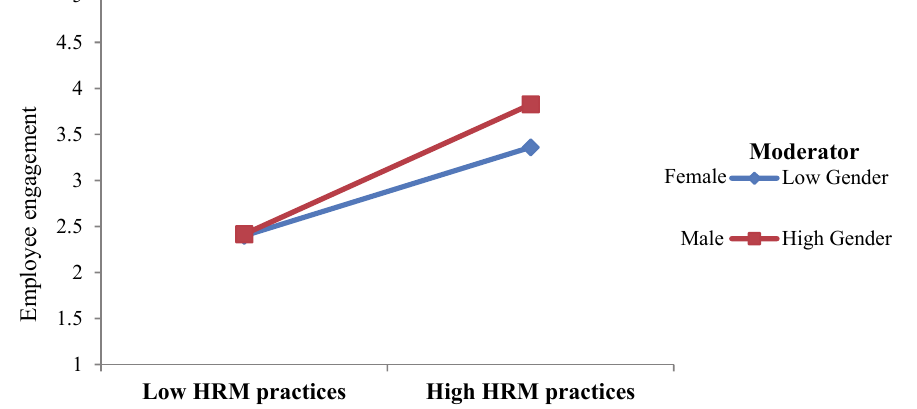
Fig. 4. the effect of HRM practices on employee engagement is stronger with male